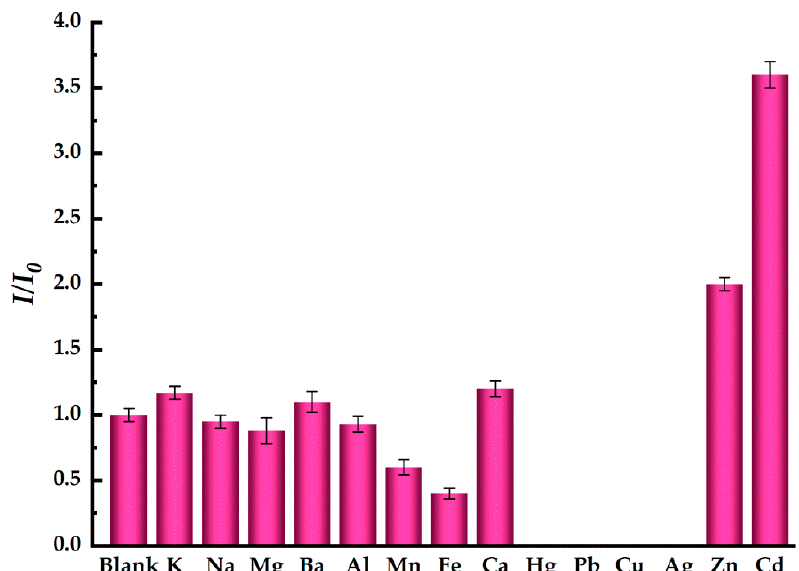
Figure 9. The effect of interfering ions on fluorescent restoration for the system of EDTA-CdSe/CdS QDs.